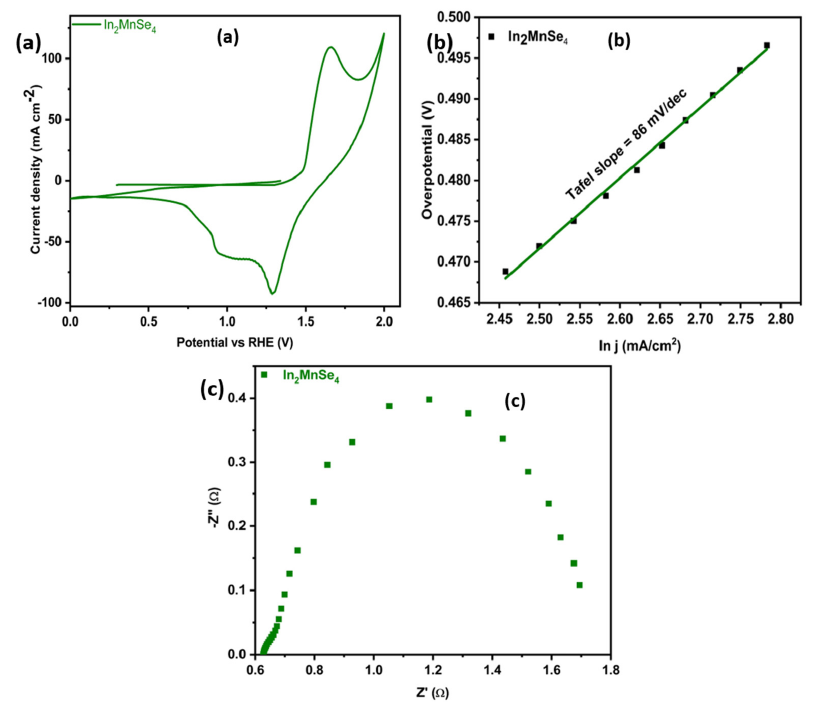
Figure 6. ( a ) Cyclic voltammogram (CV), ( b ) Tafel slope of In 2 MnSe 4 nan, and ( c ) EIS IR Corrected Nyquist plot for In 2 MnSe 4 .